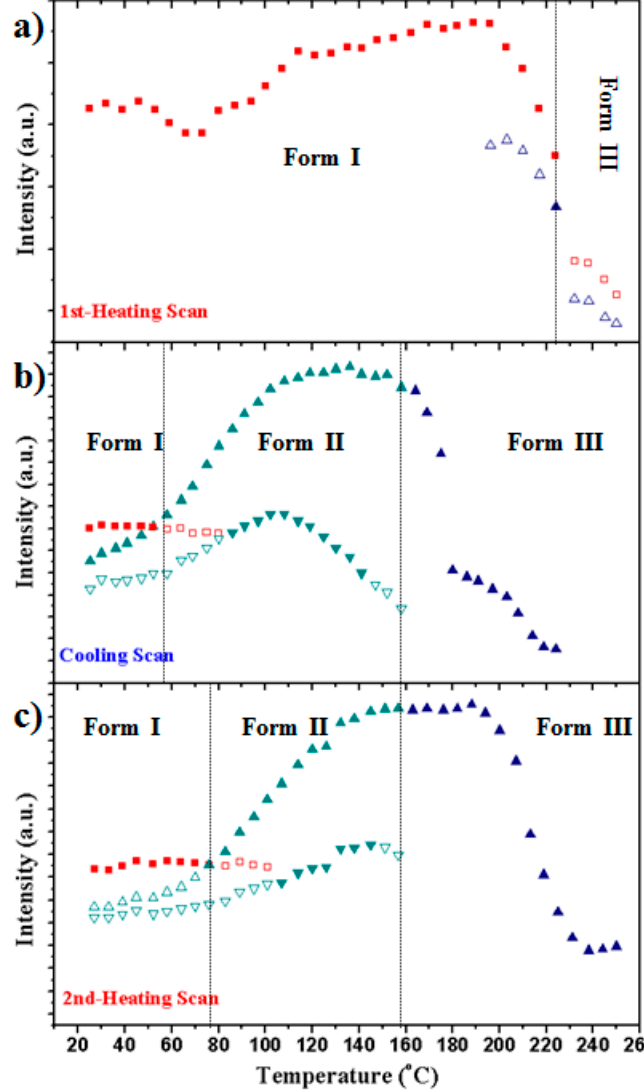
Figure 7. Temperature evolution of the intensity of the main peaks (for the clarity of representation the Form I peak at 0.375–0.410 nm is not plotted) during: the first heating ( a ); cooling ( b ); and second heating ( c ) processes. Full and empty symbols indicate well-defined and intuited reflections, respectively. The temperatures at which structural transitions occur are indicated with vertical lines. Reflections corresponding to Forms I, II and III are indicated in red, green and blue, respectively.